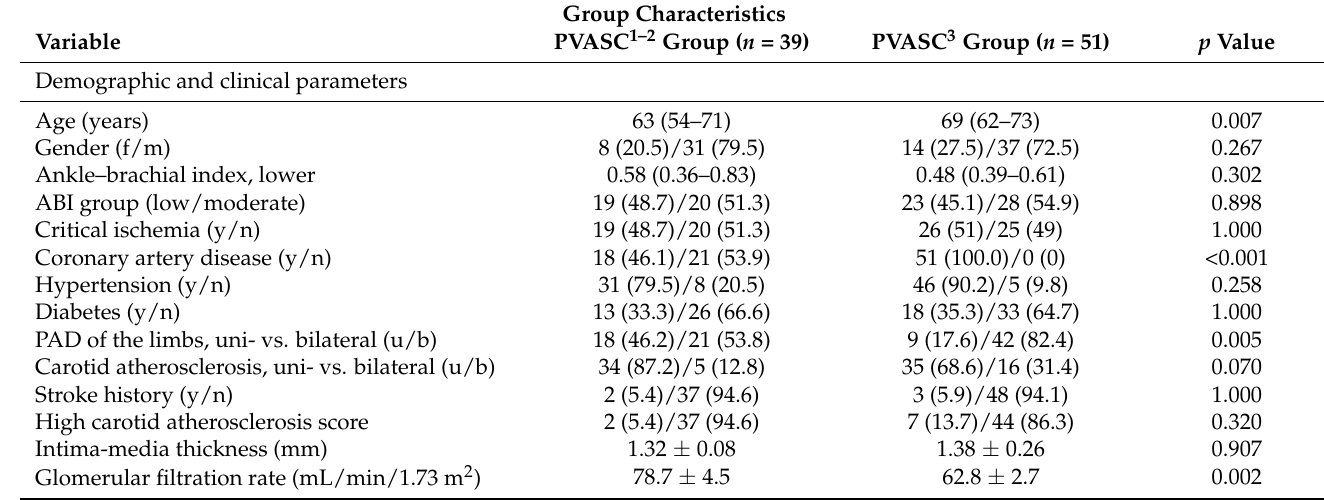
Table 3. Clinical variables of the 90 patients with one- or two-, versus three-bed involvement. Group